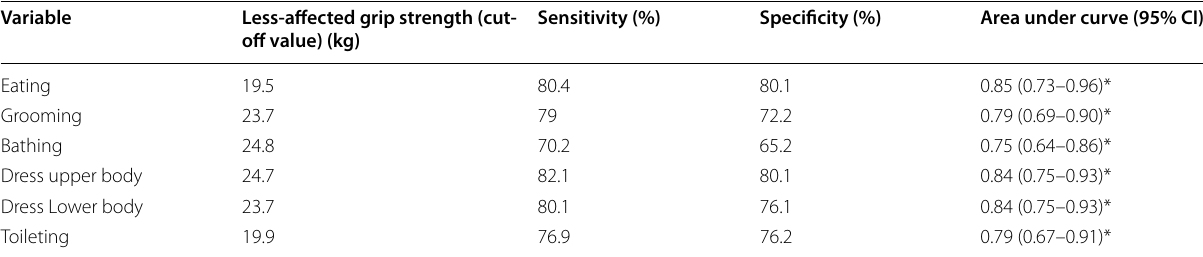
Table 5 The receiver operating characteristics of less-affected grip strength in the performance of self-care activities